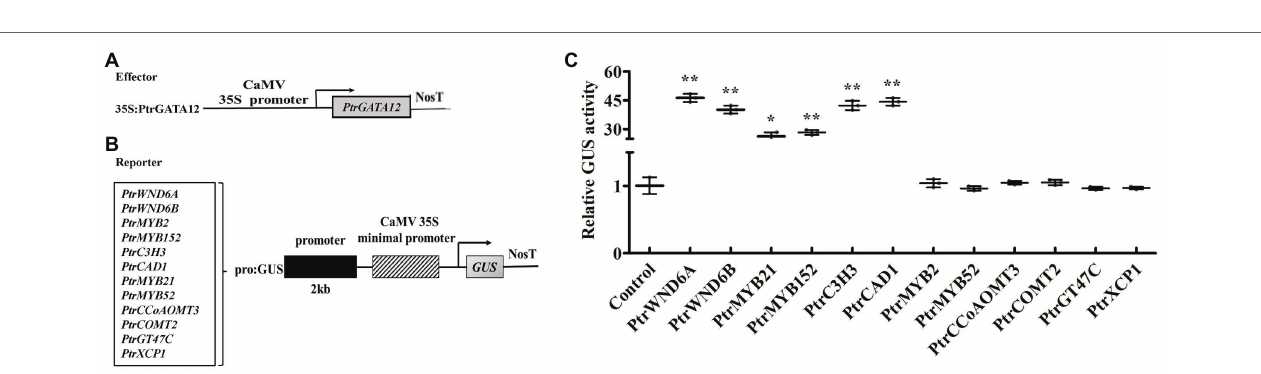
FIGURE 7 | Expression analysis of wood formation pathway genes and their regulatory TFs in 90 days old wild-type and PtrGATA12 transgenic lines. Control represents the normalized expression level (namely 1 in this case) of each wood formation gene examined in wild-type plants. Error bars represent SD of three biological replicates. Asterisks indicate levels of significance (Dunnett’s test; **, p < 0.01).